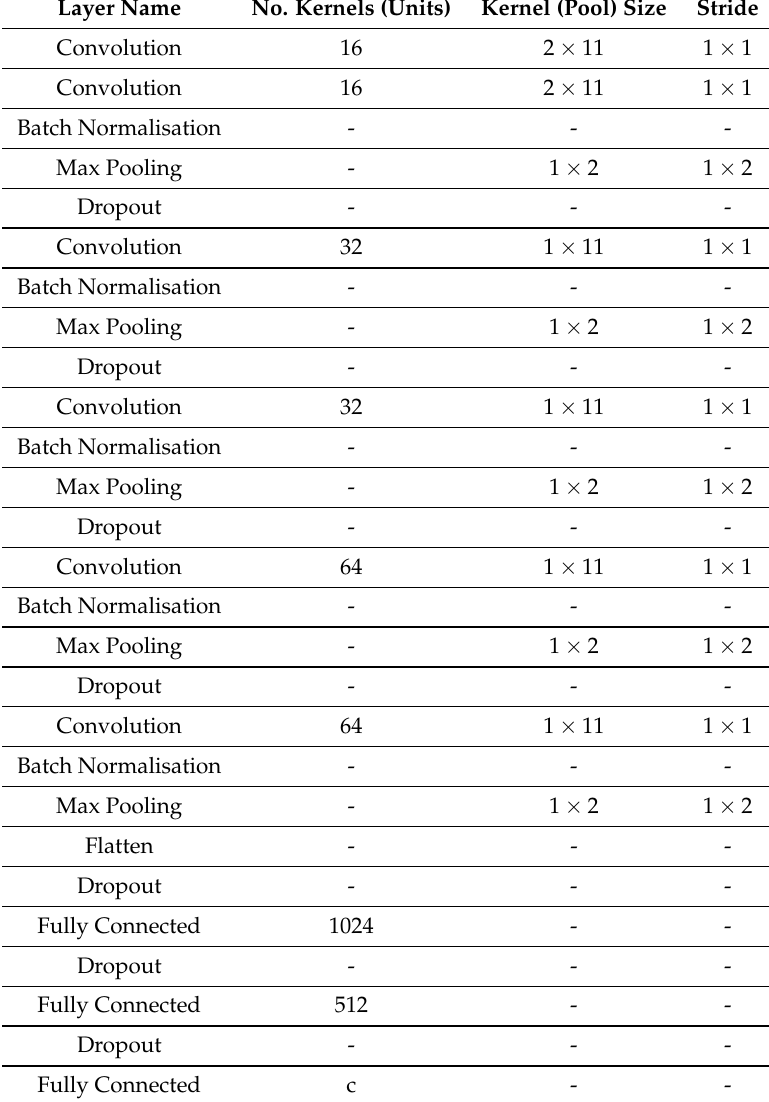
Table 2. Early fusion deep CNN